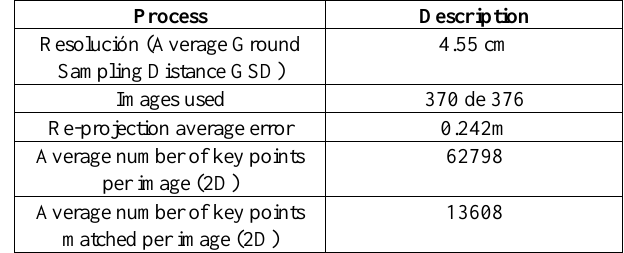
Table 5. Processing of UAV images (Jun 20,